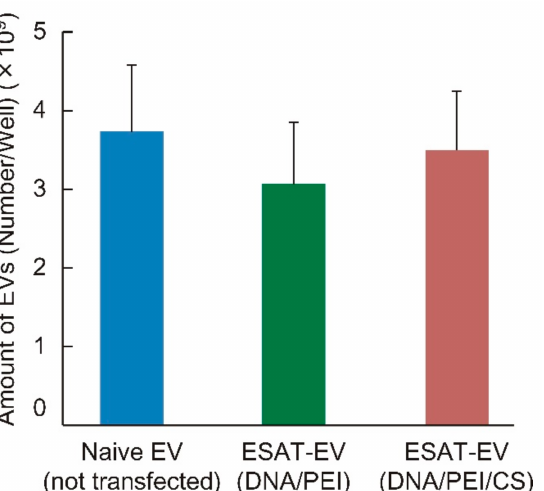
Figure 1. Extracellular vesicle (EV) production efficiency of genetically modified tumor cells. B16 melanoma cells were cultured in 24-well plates with or without the addition of the complex of pDNA coding for 6 kDa early secretory antigenic target (ESAT-6). DNA/polyethylenimine (PEI) binary complex, or DNA/PEI/chondroitin sulfate (CS) ternary complex, each containing 1.5 µ g pDNA(ESAT-6)/well, were used to introduce the gene into the cells. At 3 days post transfection, the cell culture medium was collected, and EVs from the transfected cells (ESAT-EV) and those from the non-treated cells (Naive EV) were isolated by centrifugation, followed by precipitation with total exosome isolation reagent. The particle number of the isolated EVs was evaluated using an EXOCET Exosome Quantitation Assay Kit and are presented as the number of EVs in one well ( n = 17, mean ± SD).